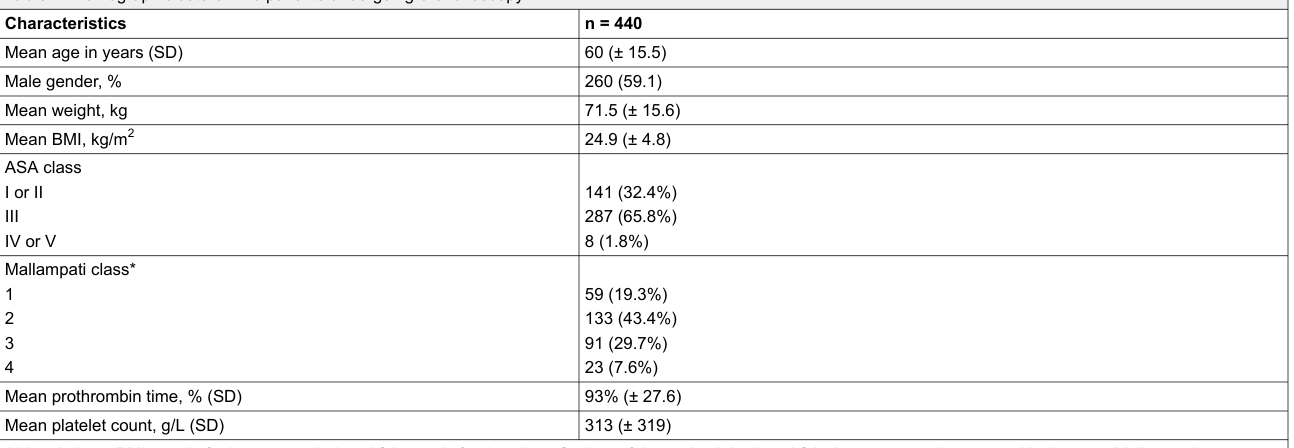
Table 1: Demographic data of 440 patients undergoing bronchoscopy.